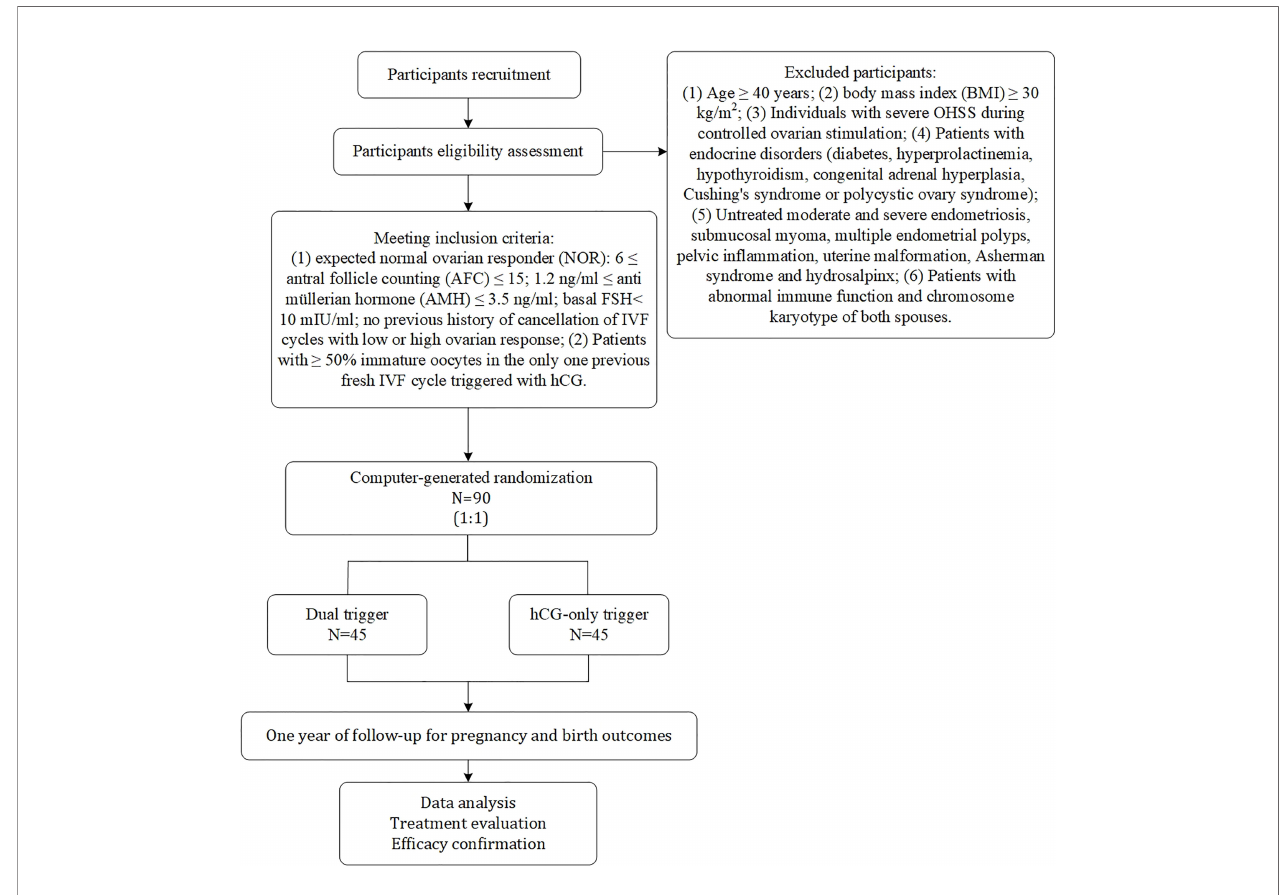
FIGURE 1 | Flowchart showing the study